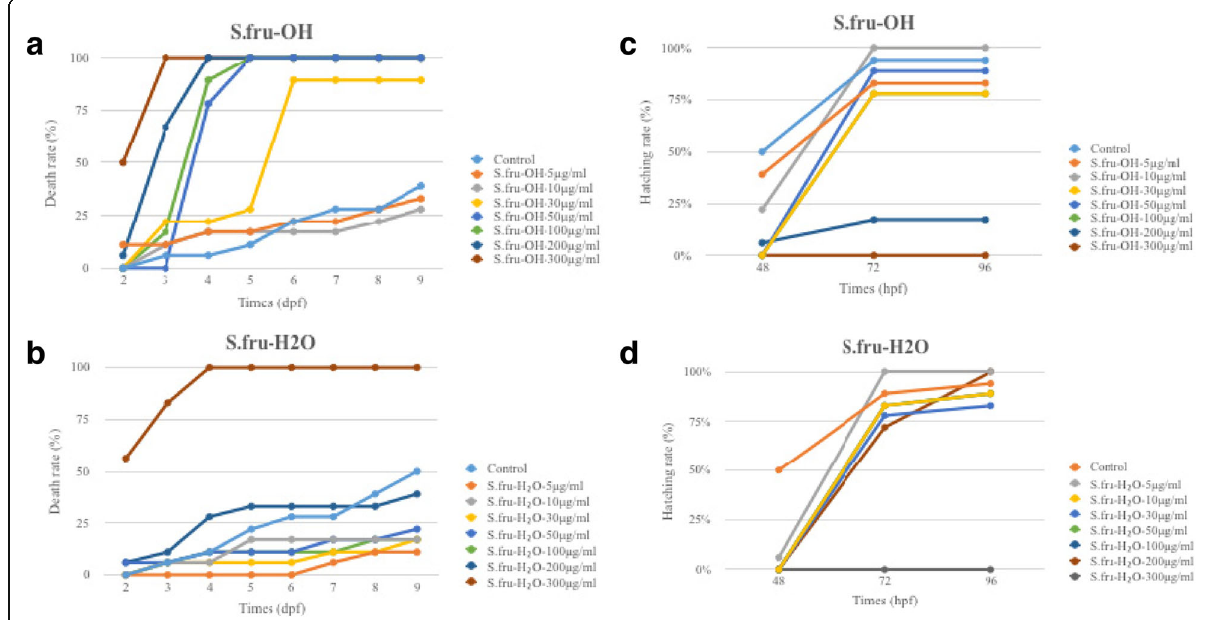
Fig. 4 The death rate of zebrafish embryos exposed to various concentrations of S. frutescens . a S.fru-OH extract and b S.fru-H 2 O were applied at 0 – 300 μ g/ml; and, the hatching rate of zebrafish embryos exposed to various concentrations of S. frutescens . c S.fru-OH extract and d S.fru-H 2 O were applied at 0 – 300 μ